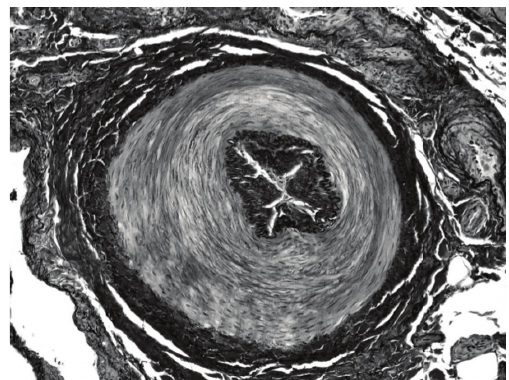
Figure 2: A biopsy specimen of the right posterior tibial artery in Case 1. The arterial wall in the media was thickened. There was no evidence of infiltration of inflammatory cells (Elastica van Gieson stain, × 40).